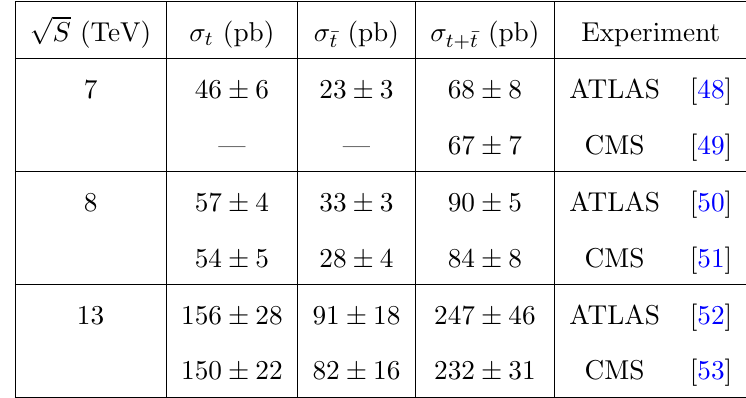
Table 3 . t -channel single-top total cross sections measured by ATLAS and